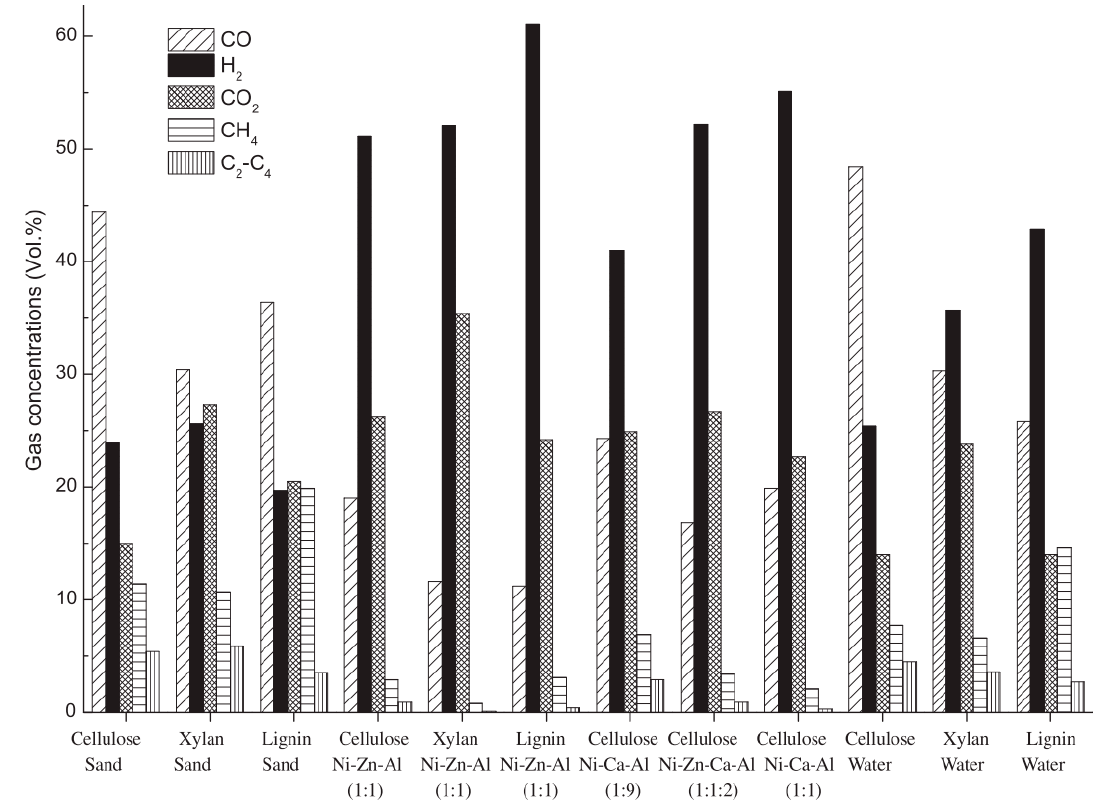
/ gasification of various samples